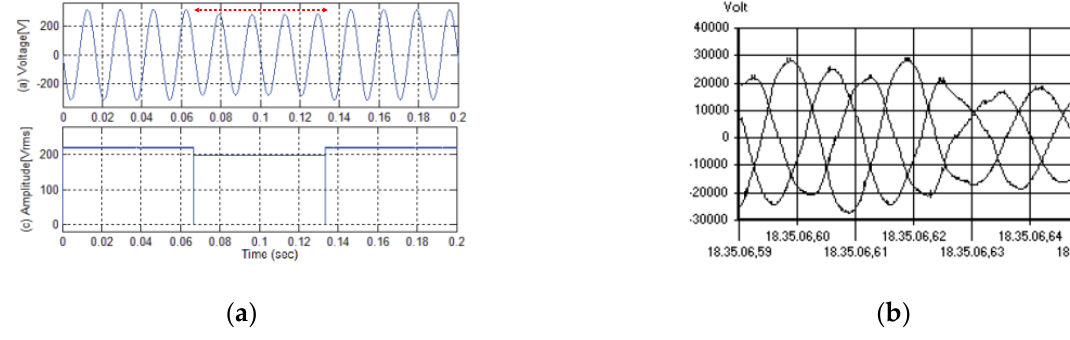
Figure 15. Measured voltage dip in Korea. ( a ) 4-cycle voltage sag signal without a noise [111]; ( b ) 63% voltage sag recorded in Rome metro line